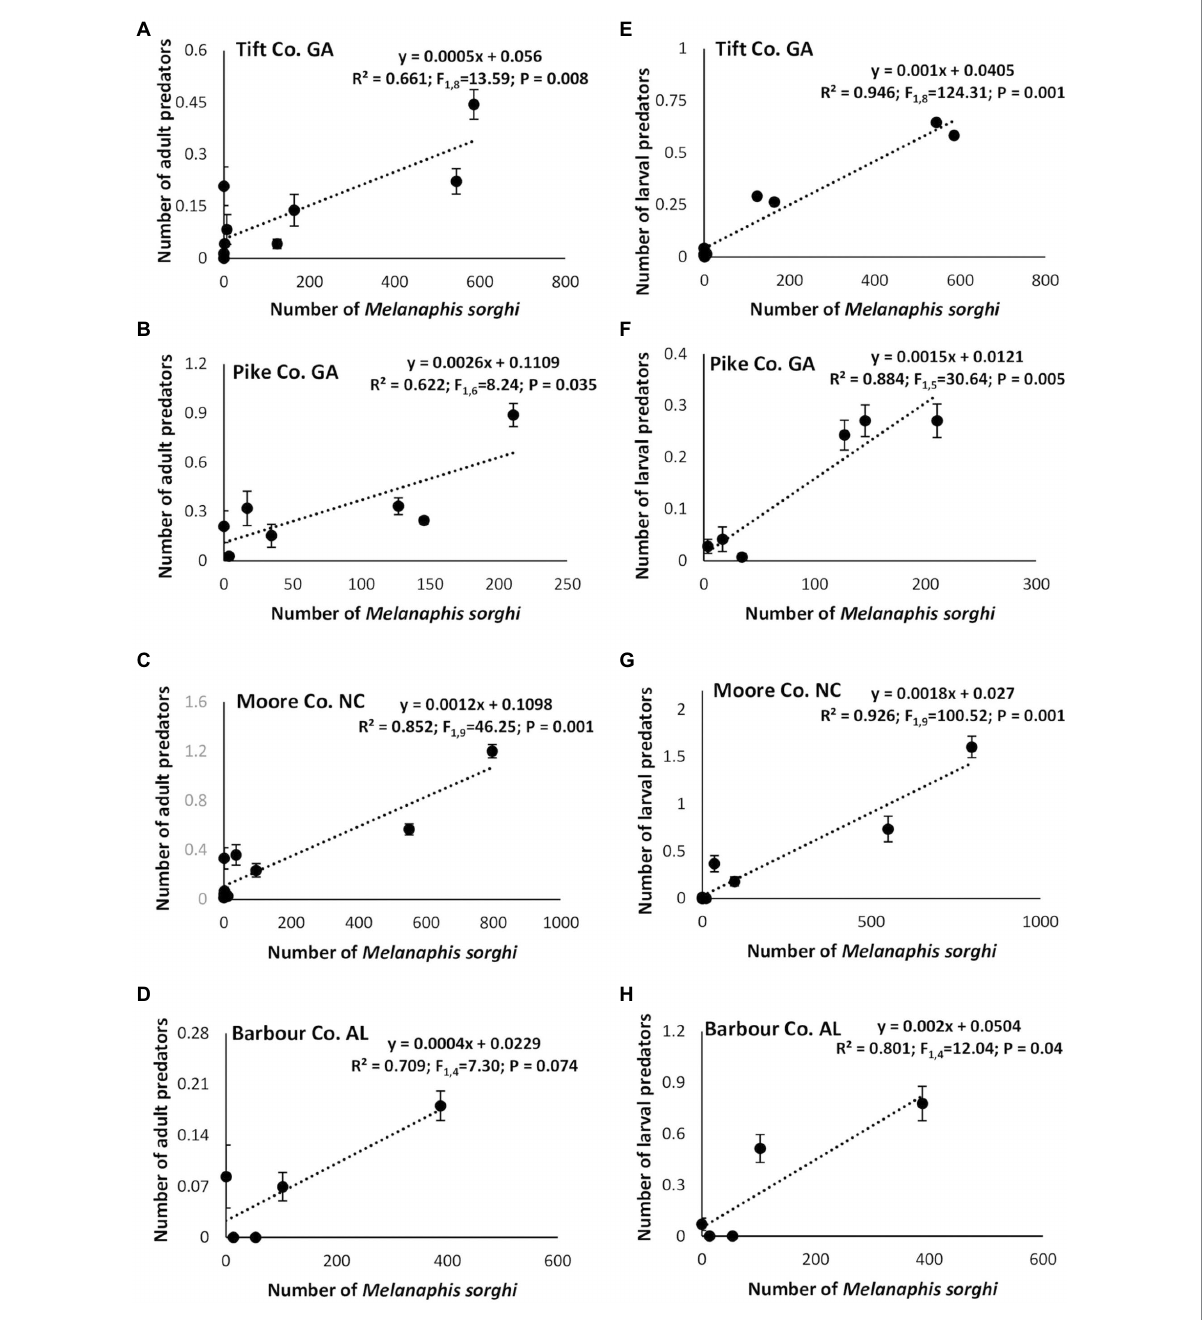
FIGURE 7 Relationships between mean (±SE) weekly Melanaphis sorghi counts and adult (A–D) or larval (E–H) predators across cultivars, insecticide treatment and locations.